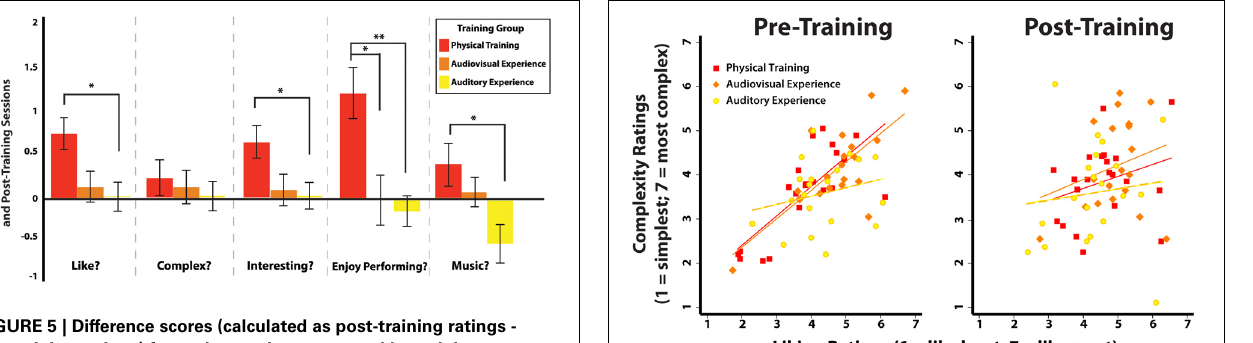
FIGURE 5 | Difference scores (calculated as post-training ratings - pre-training ratings) for each question, separated by training group. The single asterisk (*) denotes significance at p < 0 . 05 and the double asterisk (**) denotes significance at p = 0 . 002. FIGURE 6 | Correlations between complexity and liking ratings, before